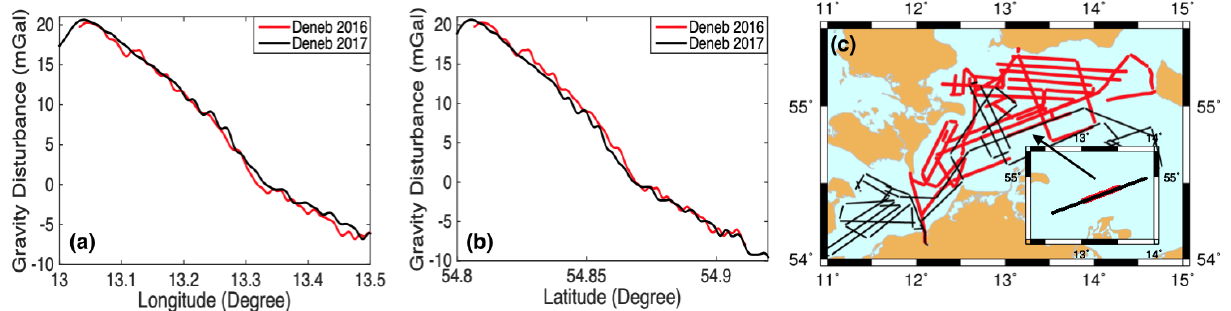
Figure 5. ( a , b ) show the repeat tracks between the marine gravimetry campaigns onboard DENEB in 2016 (red line) and 2017 (black line); ( c ) trajectories of the two campaigns in 2016 (red lines) and 2017 (black lines) where it also presents the zoomed repeat track in the right-bottom corner.